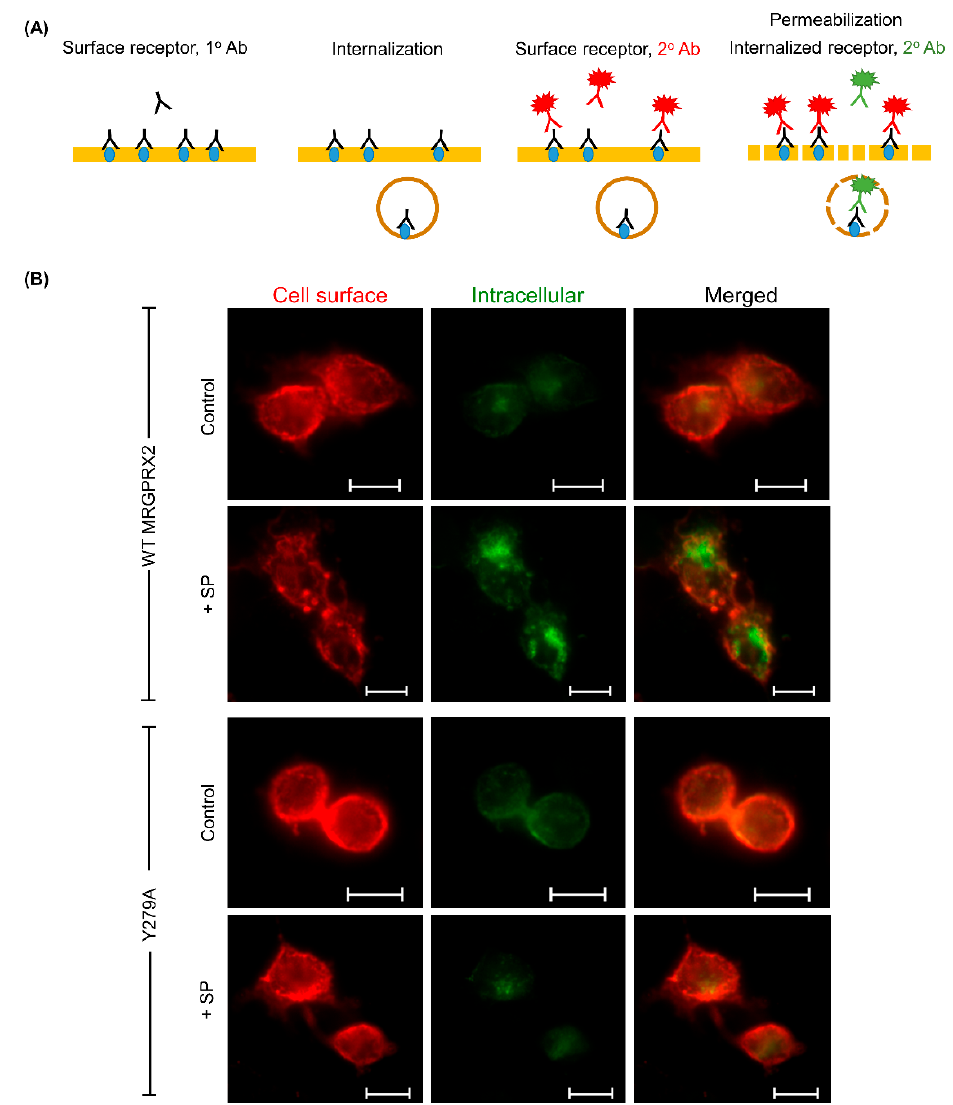
Figure 6. Y279A mutation of MRGPRX2 displays resistance to SP-induced receptor trafficking. ( A ) Schematic showing the dual-color labeling of cell surface and internalized receptors (modified from Carrodus et al., 2014 [42]). ( B ) Change in receptor trafficking was observed in RBL-2H3 cells expressing WT MRGPRX2 and Y279A mutant after SP stimulation (30 μ M; 30 min). Scale bar = 10 μ m.